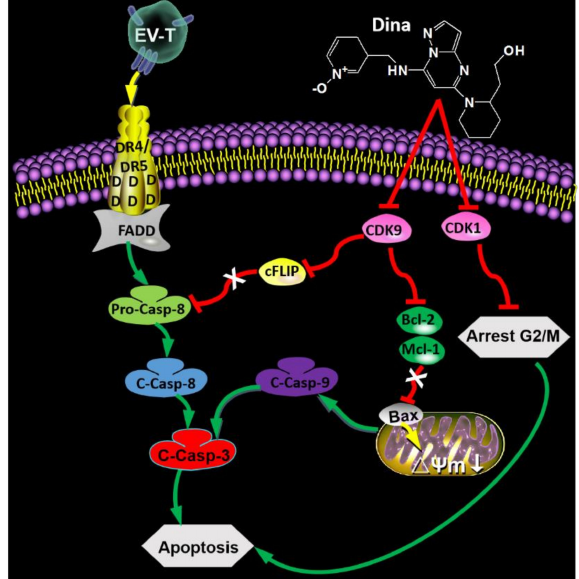
Figure 8. Schematic overview of synergism between EV-T and dinaciclib for cancer therapy. The EV-T ligand e ffi ciently binds to functional receptors DR4 and DR5, inducing trimerization of the receptors. The cytoplasmic part of the DR4 and DR5 receptors contain death domain that enable recruitment of Fas-associated protein with death domain (FADD) and pro-caspase 8 (Pro-Casp-8), enabling cleavage and activation of pro-Casp-8 to its active form caspase 8 (C-Casp-8). Casp 8 activates downstream e ff ector caspases such as caspase 3 (C-Casp-3). Dinaciclib (Dina) inhibits activity of CDK9 and CDK1 and downregulates their expression simultaneously. The CDK9 suppression results in downregulation of cFLIP and subsequent augmentation of Pro-Casp-8 activation by EV-T, decrease of Bcl-2 and Mcl-1 expression as well as upregulation of Bax, causing consequent decrease of mitochondrial membrane potential ( ∆ ψ m) and activation of pro-caspase 9 (C-Casp-9), which takes part in activation of Casp-3. Activated e ff ector caspases induce apoptosis. The suppression of CDK1 induces cell cycle arrest at G2 / M phase in which cells are prone to apoptosis